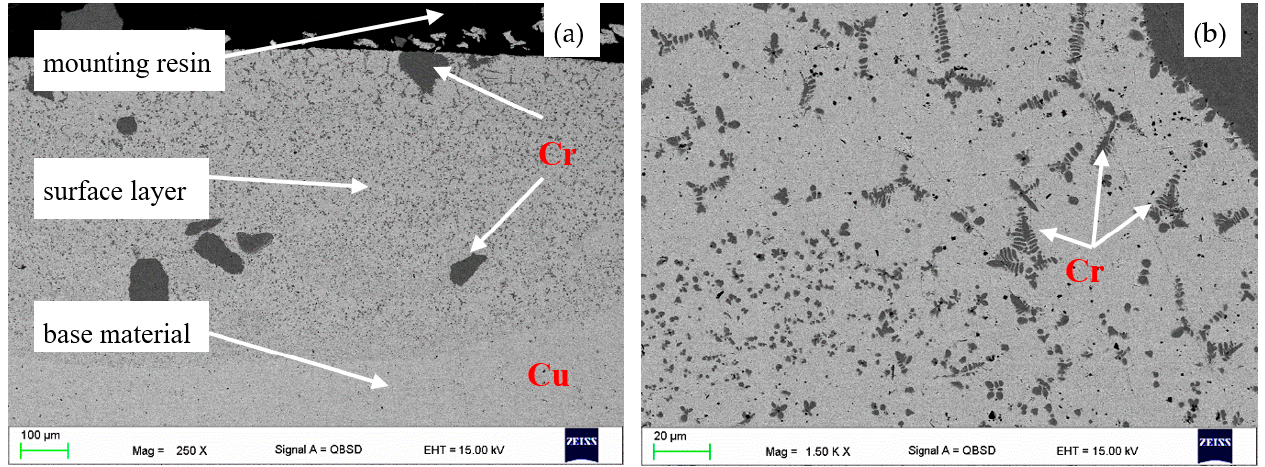
Figure 3. Cross-sectional structure of the coating obtained after fusing CrAl powder Cu-ETP copper, ( a ) surface layer zones, ( b ) chromium dendrites; laser power, melting rate; SEM.